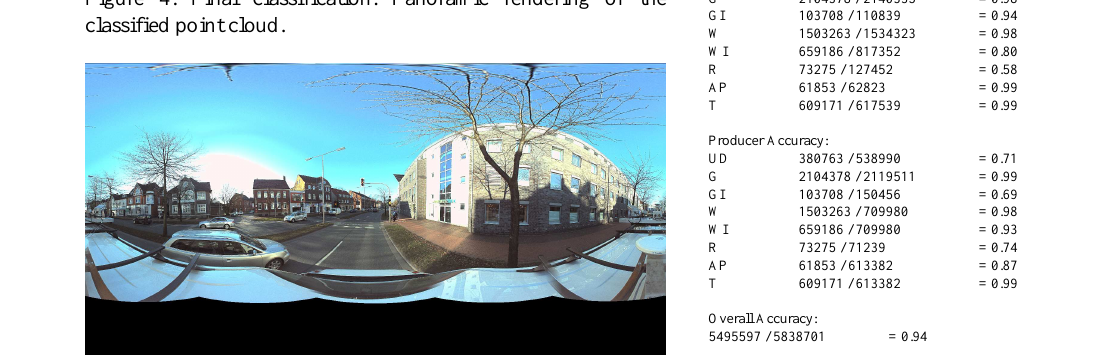
Figure 5. Panoramic image of the scene.